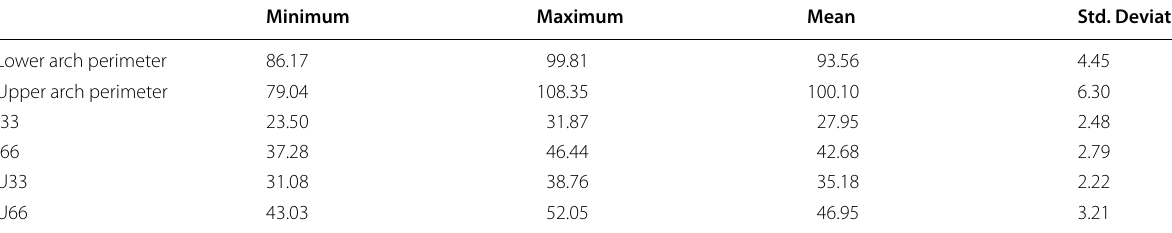
Table 1 Descriptive statistics for the different variables